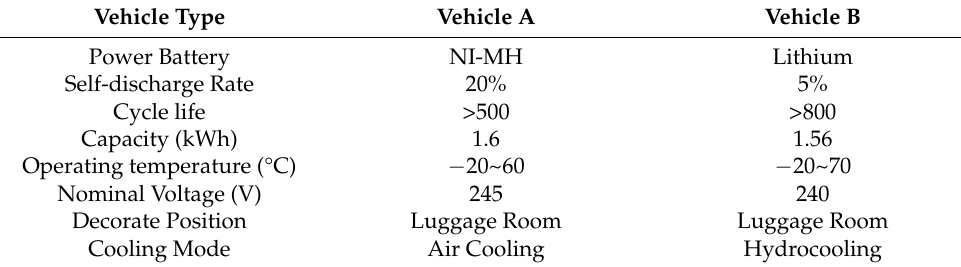
Figure 2. Two power battery packs: ( a ) Vehicle A; ( b ) Vehicle B. Table 1. Layout, types, and parameters of the studied power battery